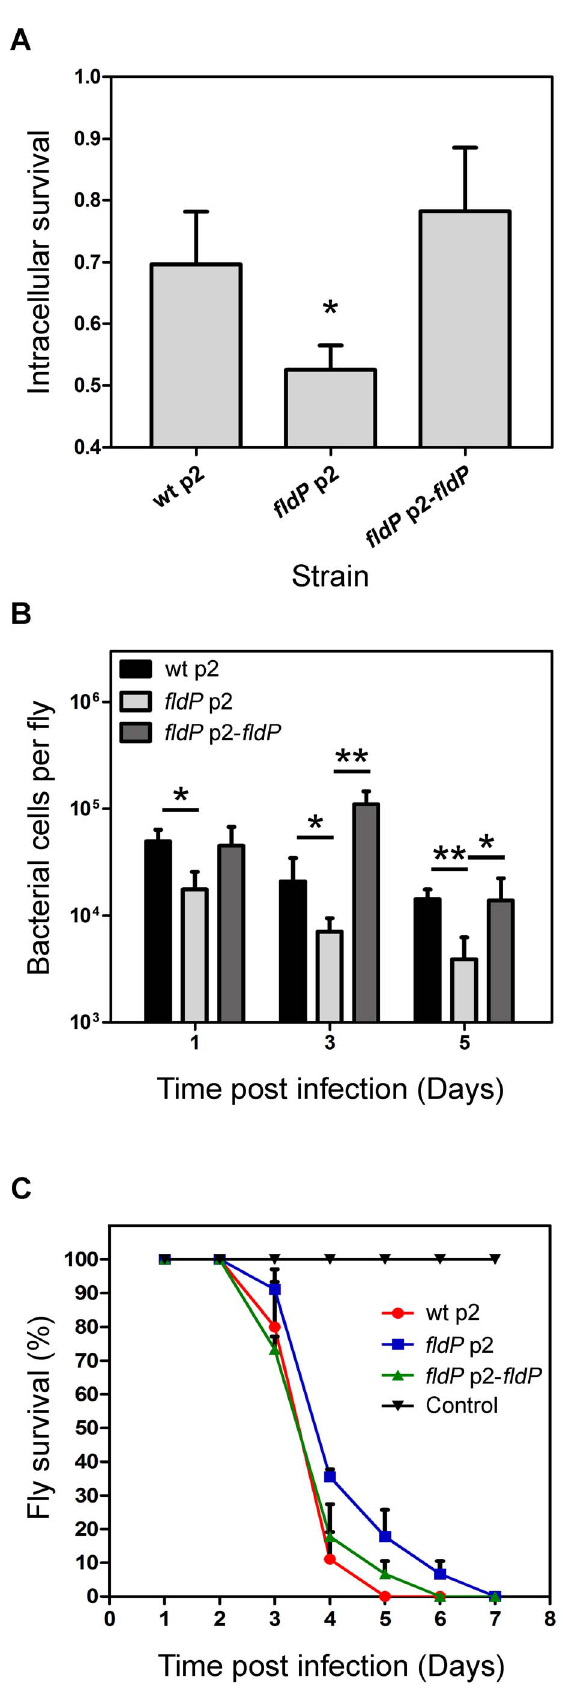
Figure 7. FldP enhances P.aeruginosa survival within mamma- lian macrophages and during in vivo infection of Drosophila melanogaster . Comparison between the P. aeruginosa wt strain and its isogenic fldP mutant complemented or not with a functional copy of the fldP gene (p2- fldP ), with respect to: ( A ) the fraction of bacteria that survived after 3 h in the intracellular milieu of RAW 264.7 macrophagic cells. Three wells of cells were used for each strain in each experiment, and all experiments were repeated three times. Statistically significant differences relative to the wt strain ( P , 0.05) are identified by * (one- tailed Student’s t test); ( B ) survival of bacterial cells within D. melanogaster flies after 1, 3 and 5 days of infection. Assays were carried out in quadruplicate for two independent experiments and the results are expressed as means 6 SEM. Statistically significant differences at P , 0.005 and P , 0.05 are identified by ** and *, respectively (one-tailed Student’s t test). ( C ) Percentage of flies that survived at each time point after being fed with the different P. aeruginosa strains. Each point of the survival curve is the average of triplicate experiments expressed as means 6 SEM. A representative experiment out of 3 is shown in the